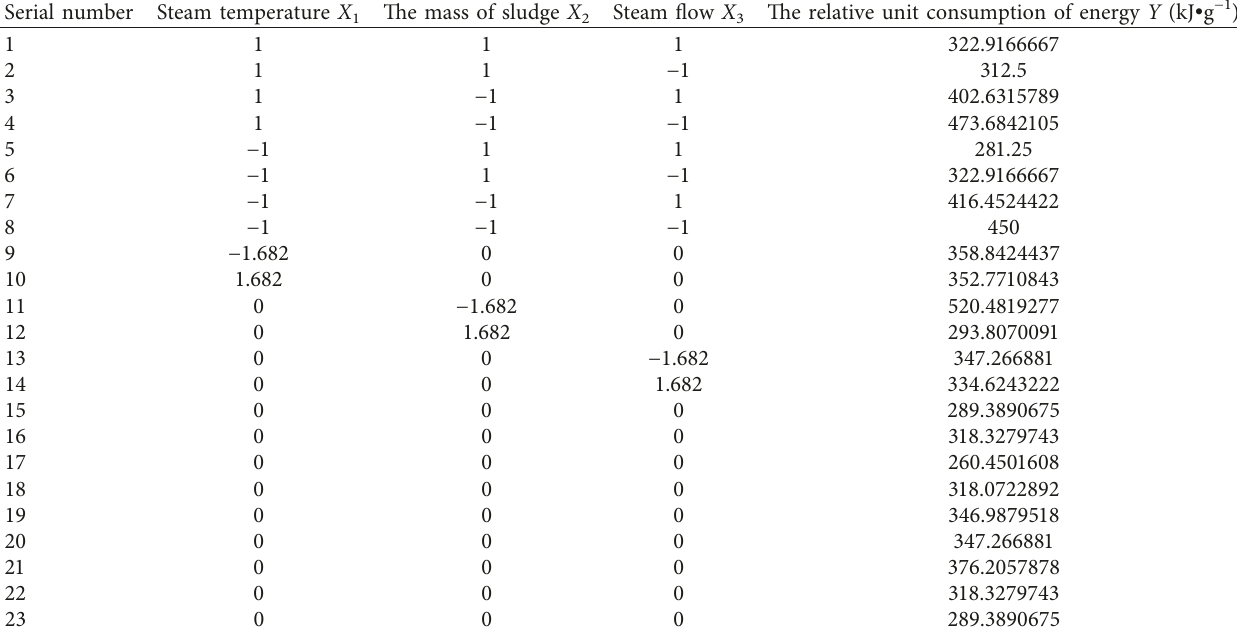
Table 10: Experimental designs and results.